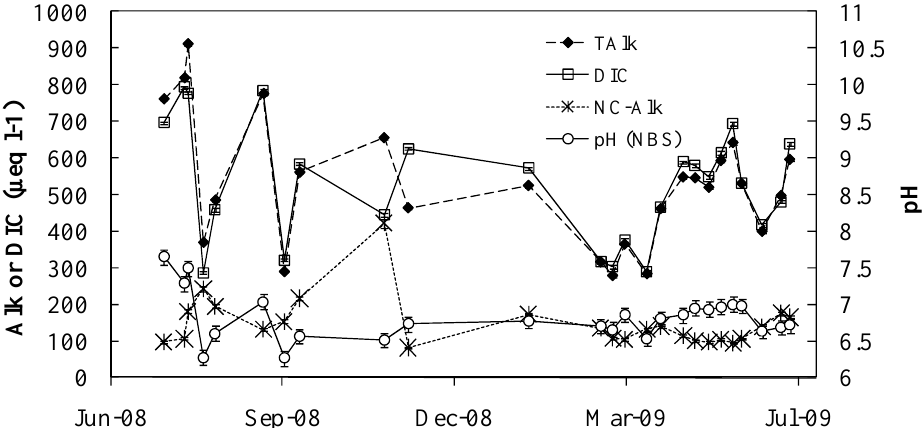
Fig. 2. TAlk, DIC and pH at one sampling location on the Oyster River. NC-Alk was calculated by subtracting TAlk DIC - pH from TAlk measured . Error bars of ± 0.1 in pH are shown, but error bars of ± 4µeql − 1 in TAlk and DIC are too small to appear in the plot.